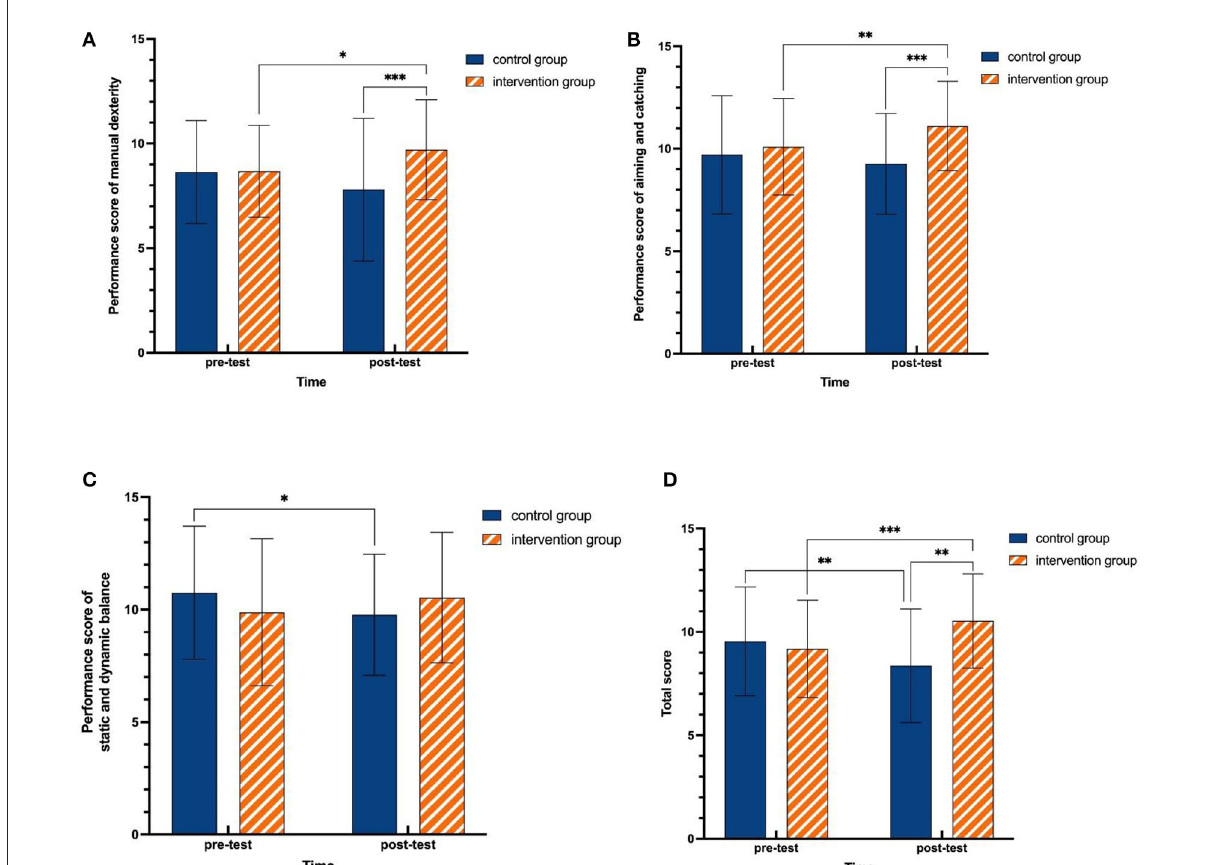
FIGURE2 Changes in MABC-2 performance. (A) Simple effect analysis results in manual dexterity. (B) Simple effect analysis results in aiming and catching. (C) Simple effect analysis results in static and dynamic balance. (D) Simple effect analysis results in total score. * p ≤ 0.05, ** p ≤ 0.01, *** p ≤ 0.001.